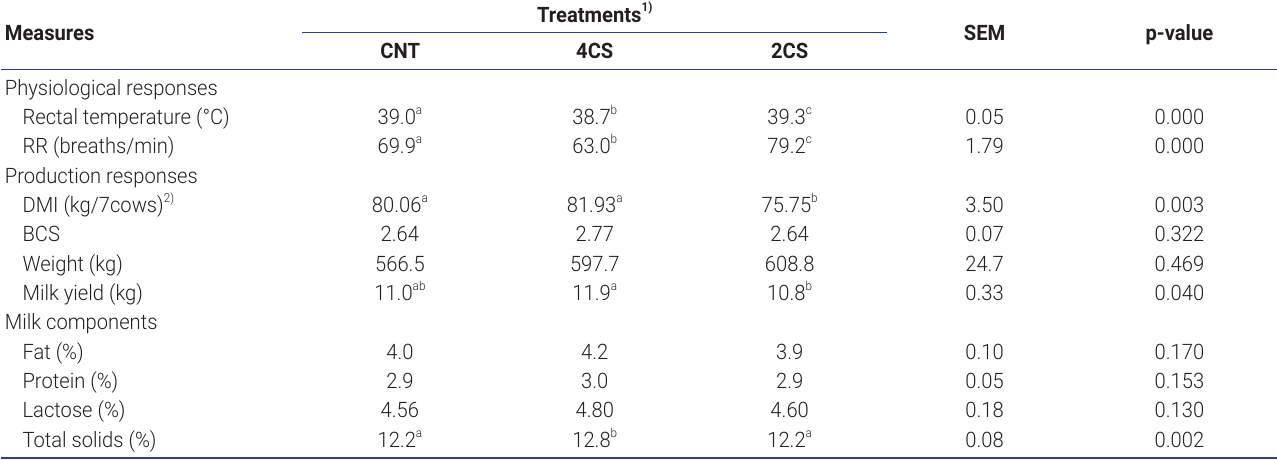
Table 3. Effect of different treatments on physiological and production responses of Holstein Friesian cows during summer (n = 21)